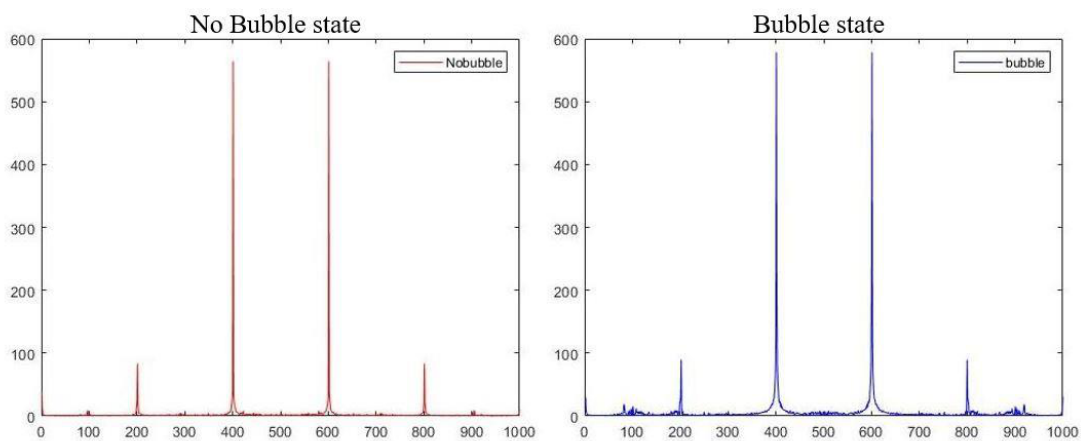
Figure 2. Comparison of FFT spectrum for healthy and faulty states.